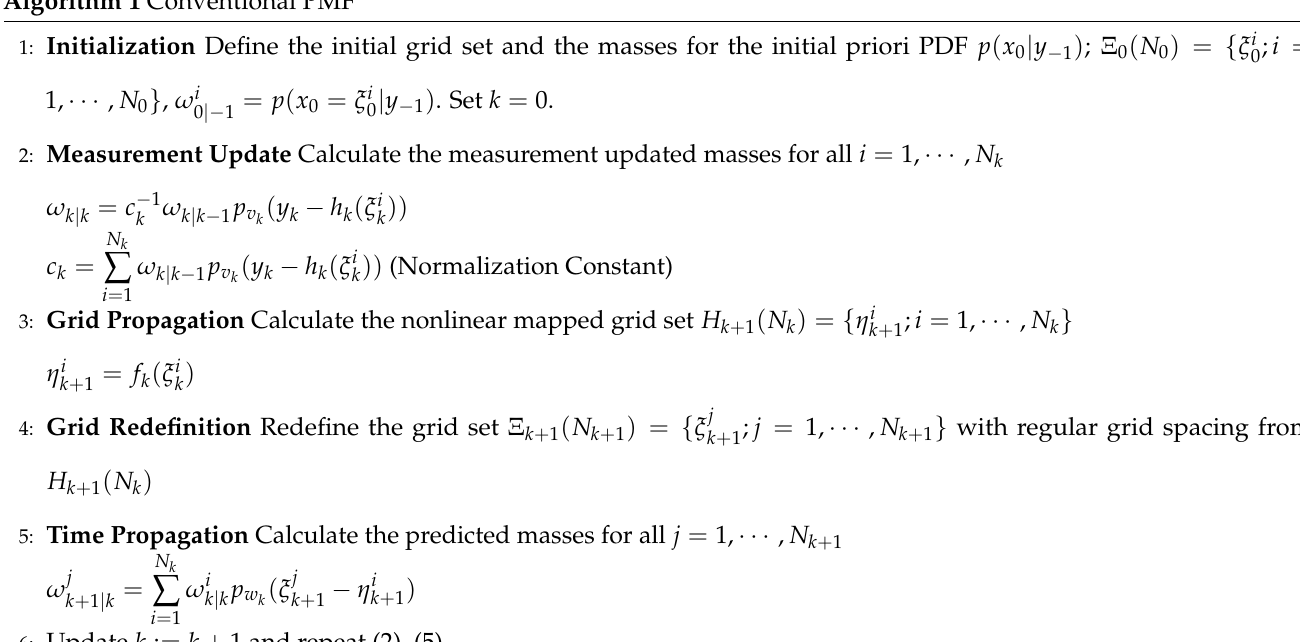
Algorithm 1 Conventional